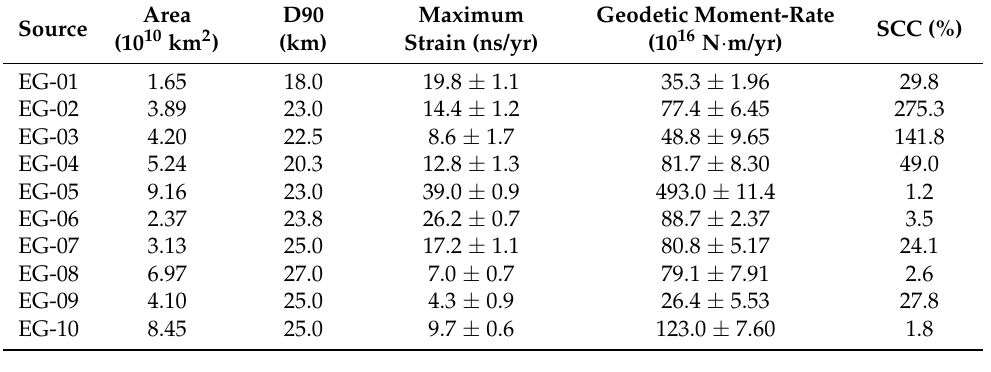
Table 3. Area of the proposed sources, seismogenic thickness (D90) with 10% variation for both lower and upper ranges, maximum strain (nanostrain/year), and their corresponding geodetic moment-rates. Seismic coupling coefficients (SCC %) estimated from the geodetic-seismic moment-rates ratio are also included.